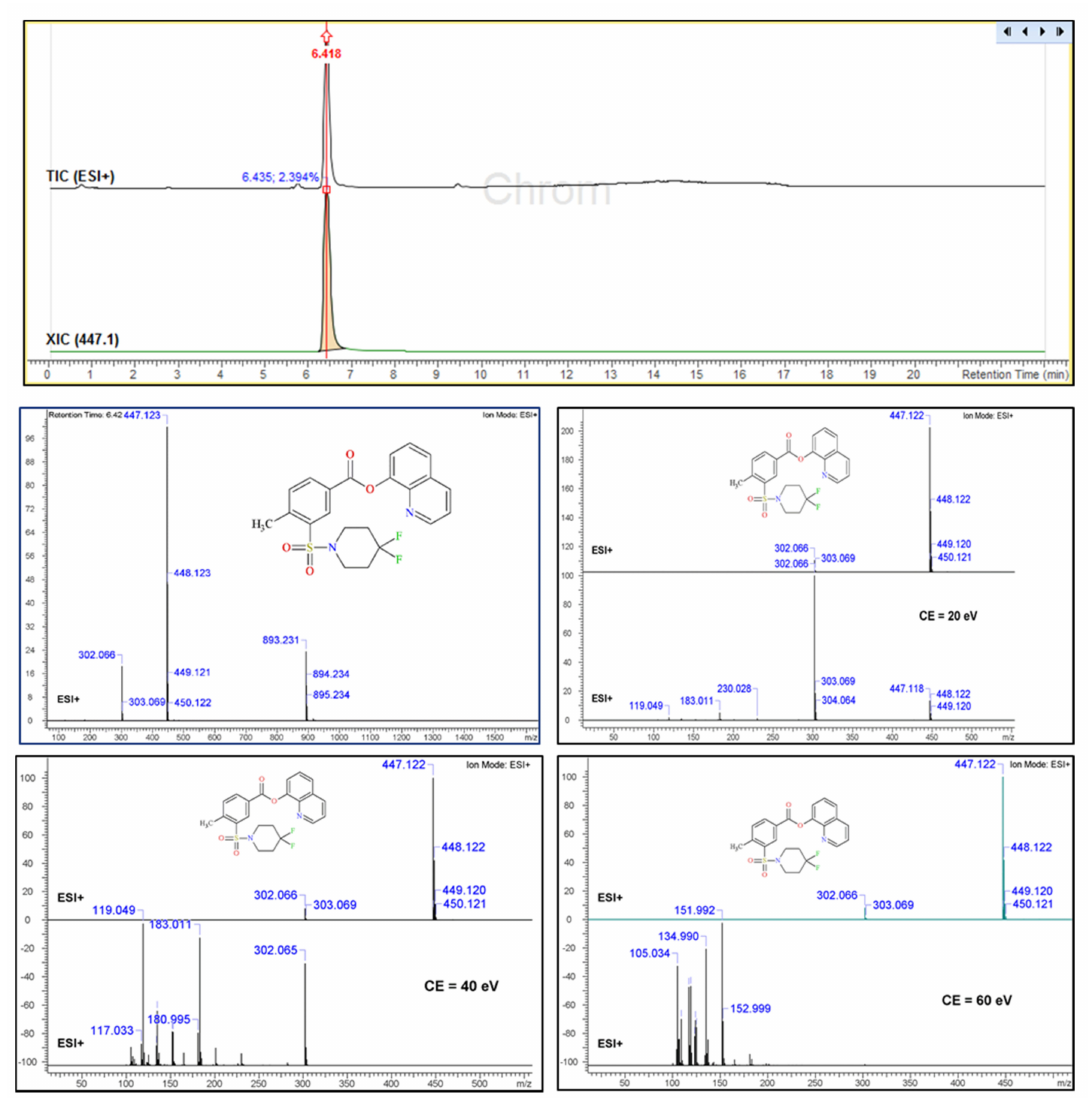
Figure 4. UHPLC-ESI(+) qTOF-MS TIC, MS and MS/MS spectra (20, 40 and 60 eV) of the identified cannabinoid